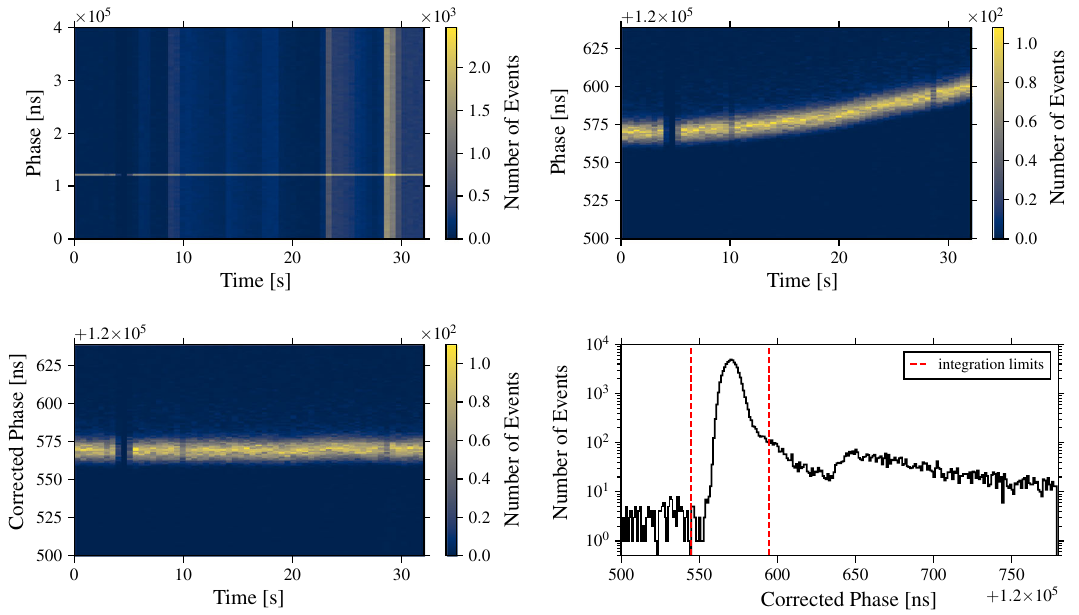
Fig. 4 Avisualrepresentationofthesignalextractionprocessusing32 seconds of data from a single PMT. Top left: Plotting the phase (event time modulus POCAM interval T ) over time shows the POCAM sig- nal as a horizontal line at a phase of approximately y = 1 . 2 · 10 5 ns. The background rate changes slowly over time due to biolumines- cence, resulting in vertical lines. Top right: Zooming in on the y-axis at y = 1 . 2 · 10 5 ns and using a finer binning, the effect of the clock drift becomes visible. Gaps can be seen where data exceeding the DAQ capabilites were discarded. Bottom left: After adding small first- and second-order corrections to T , the POCAM signal has an almost con-